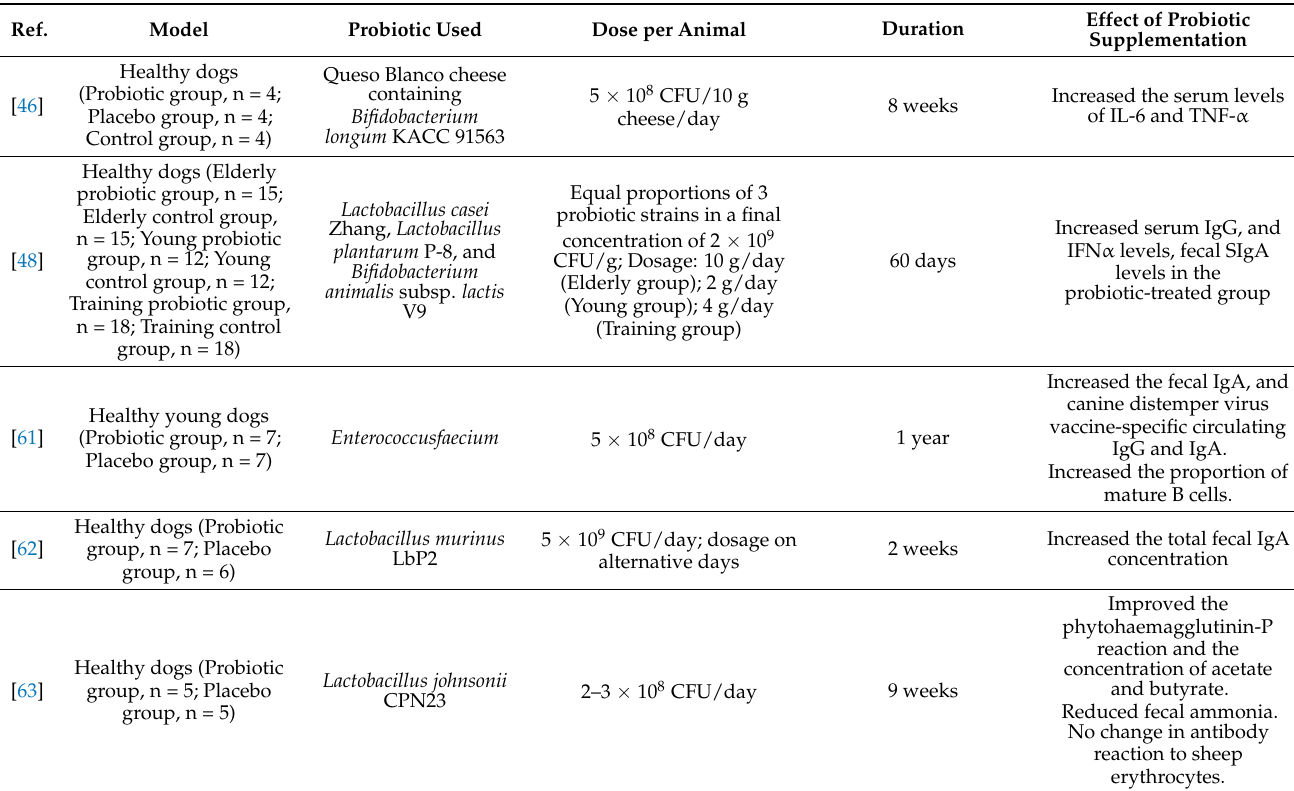
Table 2. The immune-modulatory effect of probiotic supplementation on the health status of dogs.